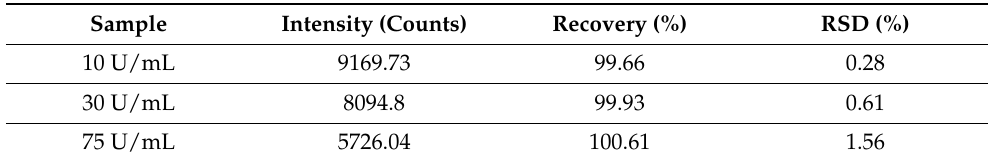
Table 1. Evaluation of the reproducibility of the sensor by testing it with commercial serum spiked with the CA 15-3 protein (n = 3).